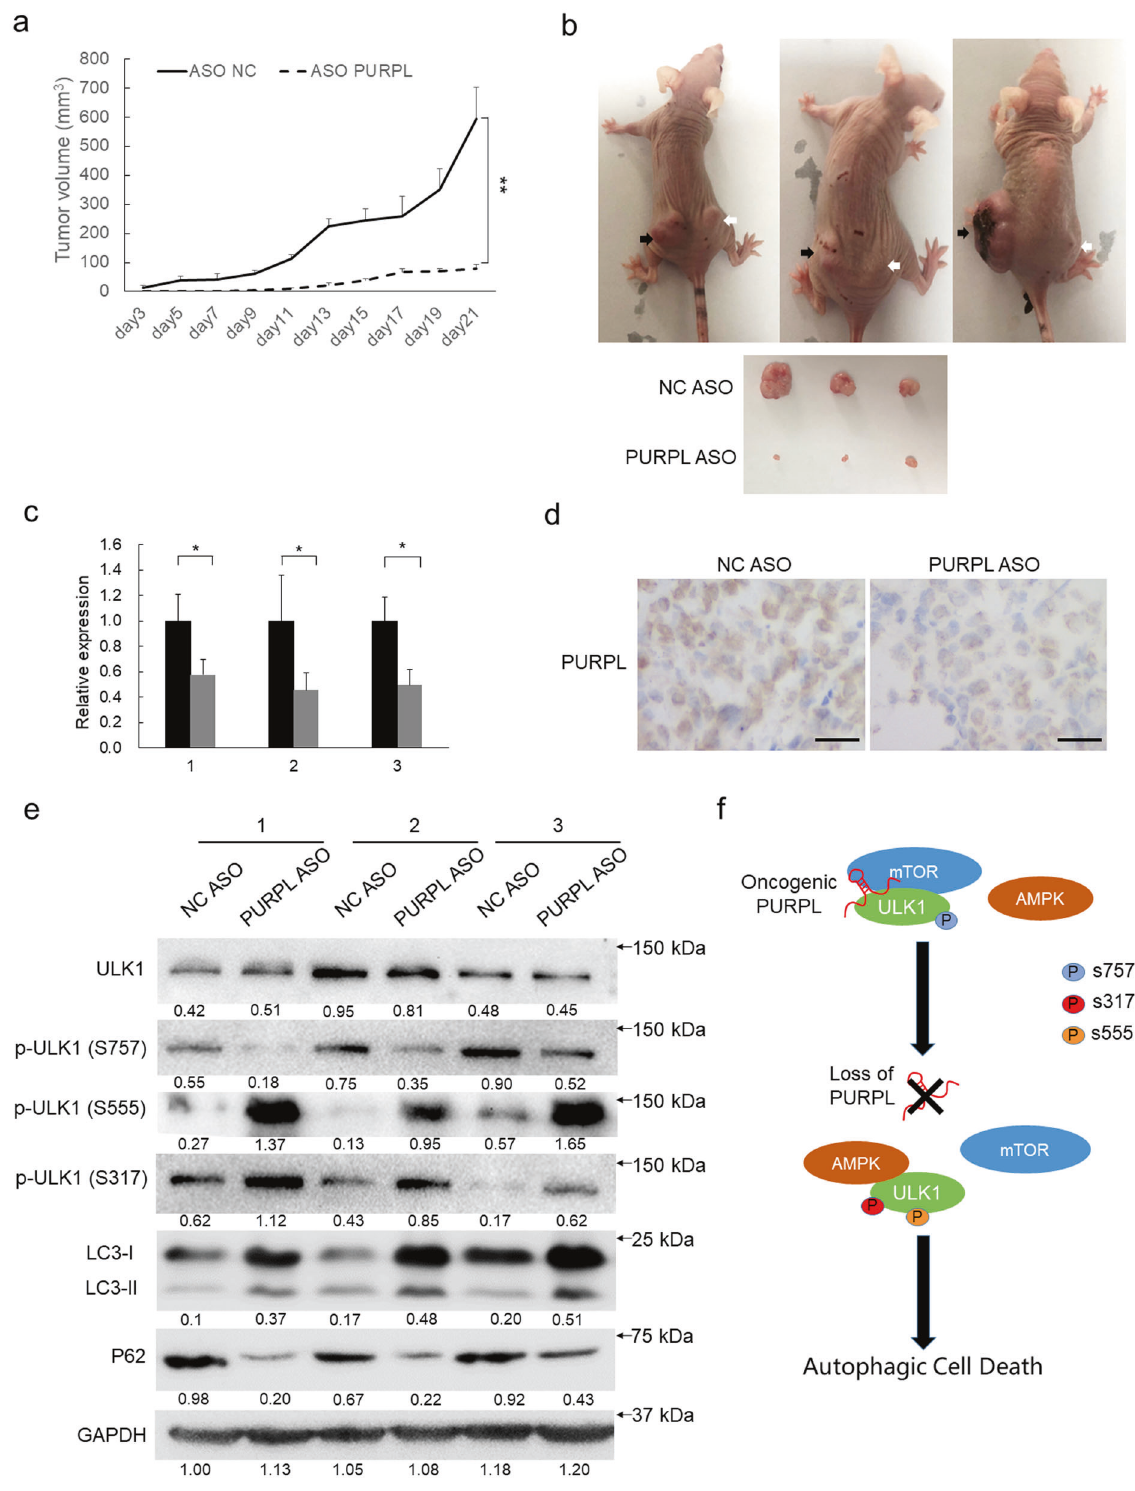
Fig. 7 Loss of PURPL activates autophagic cell death and represses tumor growth in vivo. a Loss of PURPL inhibits subcutaneous melanoma growth in a mouse xenograft model. Tumor volumes (mm 3 ) were plotted according to day. The statistical data represent the average of three independent experiments ±s.d, respectively. b The mice were sacri fi ced at the end of the experiment and the dissected tumors from three representative mice are shown. black arrows indicate the NC ASO-treated xenografts whereas white arrows indicate PURPL ASO-treated xenografts. c PURPL expression was measured in the dissected tumors by qPCR. The statistical data represent the average of three independent experiments ±s.d. d The expression levels of PURPL in tumor sections were evaluated using in situ hybridization. Scale bar, 100 µm. e Protein amount of total ULK1, phosphorylated ULK1, LC3B, and p62 was detected in paired control and PURPL-depleted groups by western blot, GAPDH was used as loading control. f A model depicts PURPL interacts with mTOR and ULK1 to differentially regulate ULK1 phosphorylation to repress autophagic cell death and promote melanoma development. Cell Death and Disease (2021)